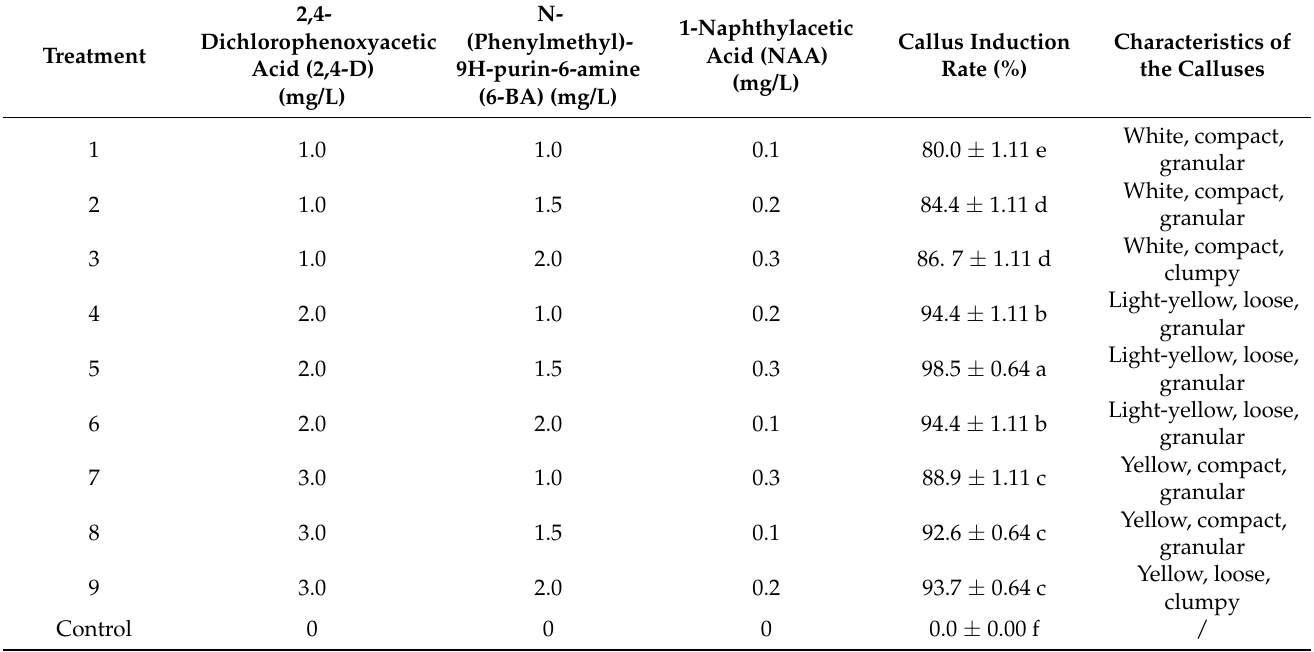
Table 1. Effects of different combinations of plant growth regulators (PGRs) on callus induction rate and characteristics of peony petals 30 days after explant